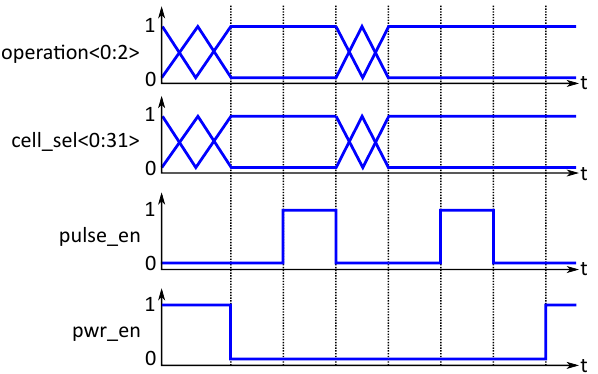
Figure 3. System waveforms: the operation<0:2> bits determine the voltage levels, while the cell_sel<0:31> signals activate the cells to interact with. The pulse_en signal triggers the operation, while pwr_en is used to switch the memory block on and